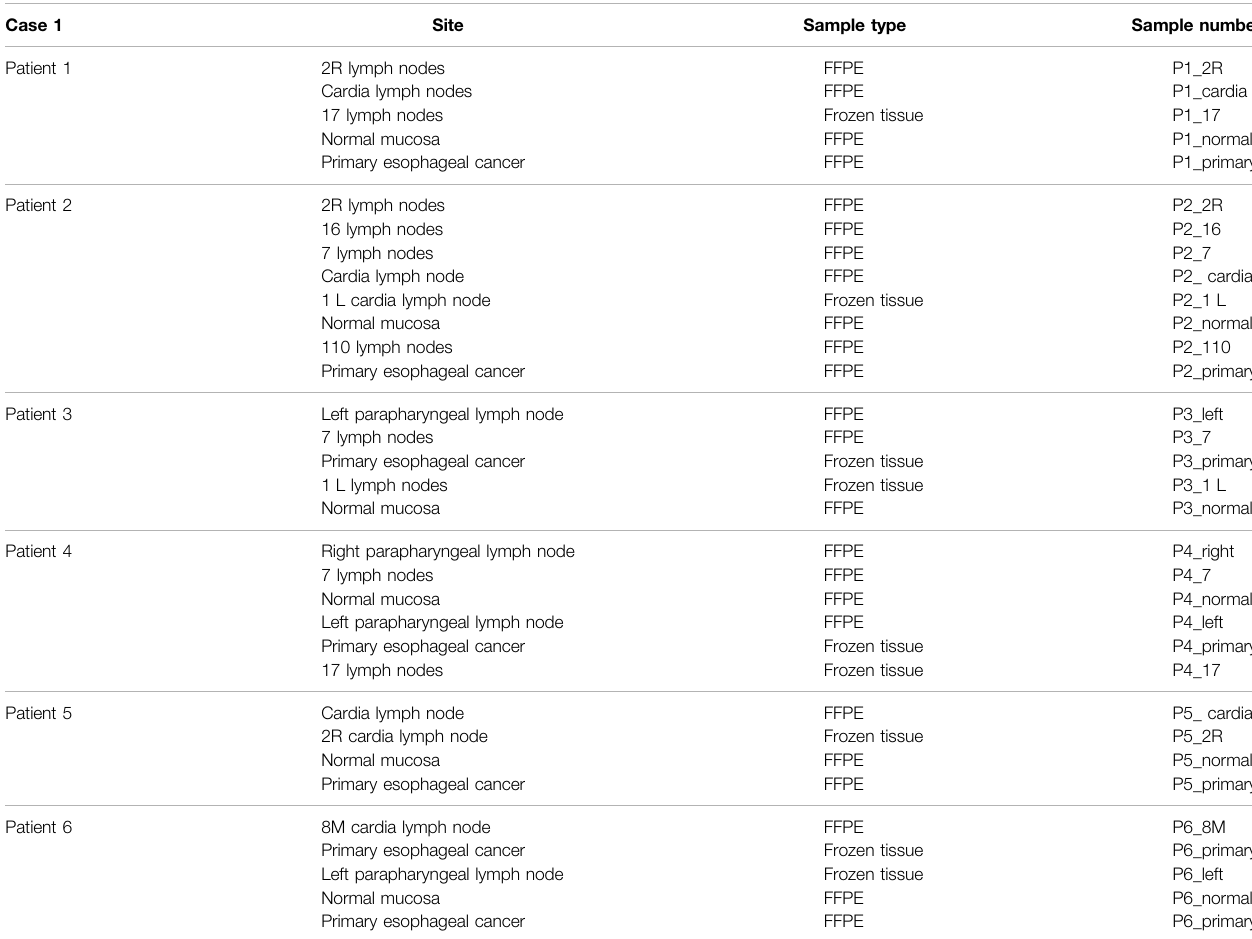
TABLE 1 | Information of all samples in six patients.